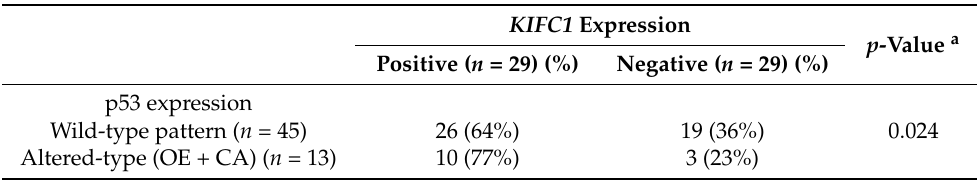
Table 7. Clinicopathologic characteristics of 46 bladder cancer patients who were treated with cis- platin based chemotherapy. Number of Cases